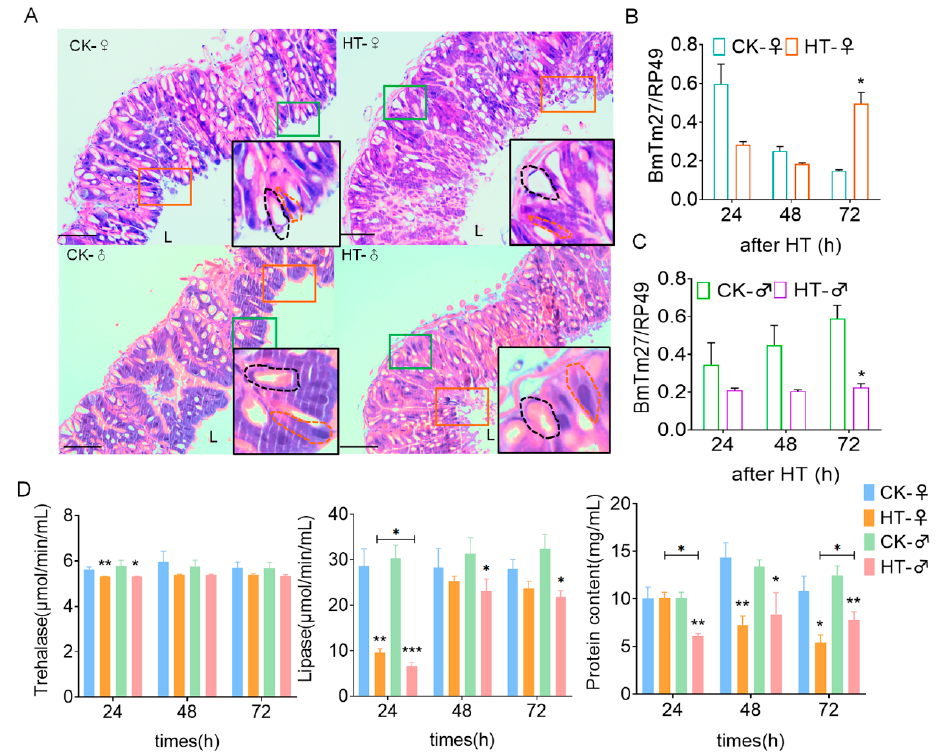
Figure 2. The effect of high temperature on the digestion and absorption in silkworm. ( A ) HE staining of a section of the silkworm midgut tissue. The midgut tissue was taken out after the silkworm was treated with high temperature (34 °C) for 72 h. The red dotted line represents cylindrical cells, the black dotted line represents goblet cells, and L represents the intestinal lumen. Bar = 100 μ m. ( B ) Transcription level of the BmTmC27 gene in midgut tissue of female silkworm. ( C ) Transcription level of the BmTmC27 gene in midgut tissue of male silkworm. ( D ) The activity and protein content of lipase and trehalase in digestive juice during high-temperature treatment. *, p ≤ 0.05; **, p ≤ 0.01; ***, p ≤ 0.001. CK, control group; after HT, high-temperature treatment.